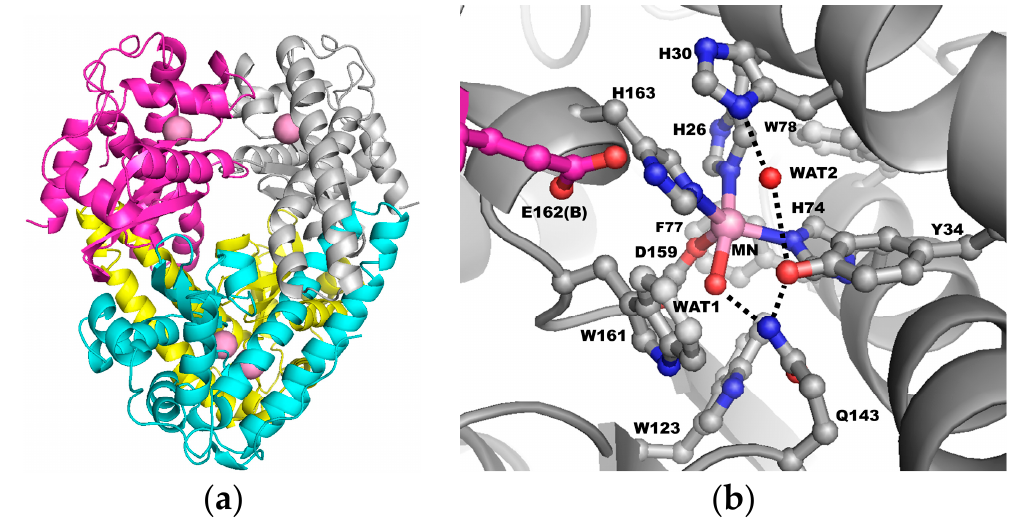
Figure 1. Human MnSOD. ( a ) Each subunit contains a manganese ion at the catalytic center, indicated by pink spheres. ( b ) The active site. Red spheres denote oxygen atoms, blue denotes nitrogen atoms, grey denotes carbon atoms from one subunit of the tetramer, and magenta denotes carbon atoms from the adjacent subunit. The dashed lines represent the hydrogen bond network hypothesized to be the proton relay to the manganese ion used for catalysis. Glu162 hydrogen bonds with His163 across the dimer interface. Adapted from Azadmanesh et al., 2017, PDB entry 5VF9 [44]. WAT1: single oxygen-containing molecule; WAT2: single oxygen-containing molecule. Single letter amino acid code is used.